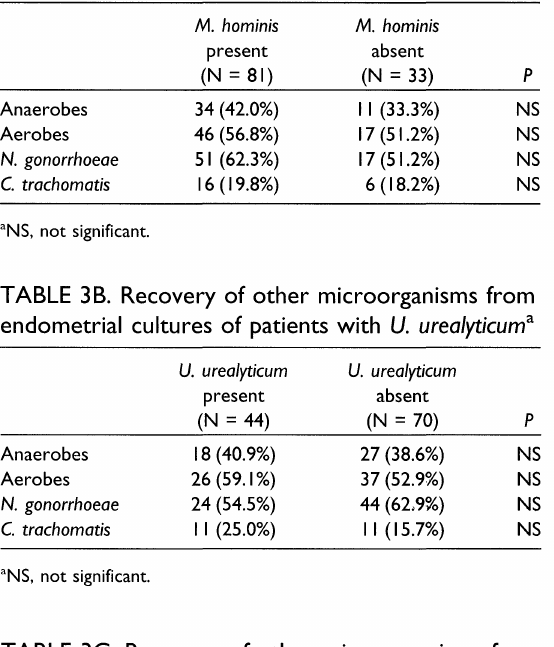
TABLE 3C. Recovery of other microorganisms from endometrial cultures of patients with both M. hominis and U. urealyticum